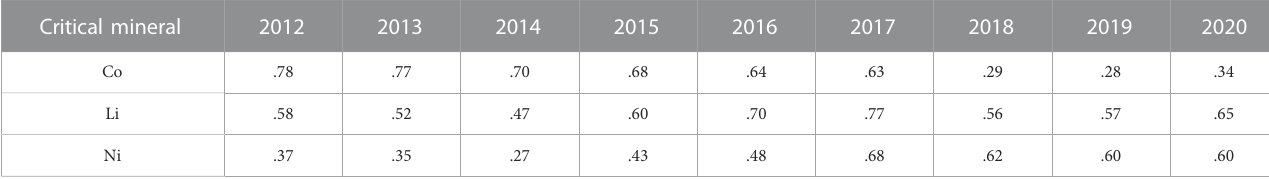
TABLE 11 The results of the comprehensive evaluation of the supply risk of cobalt, lithium, and nickel resources in China with the AHP weights. Critical